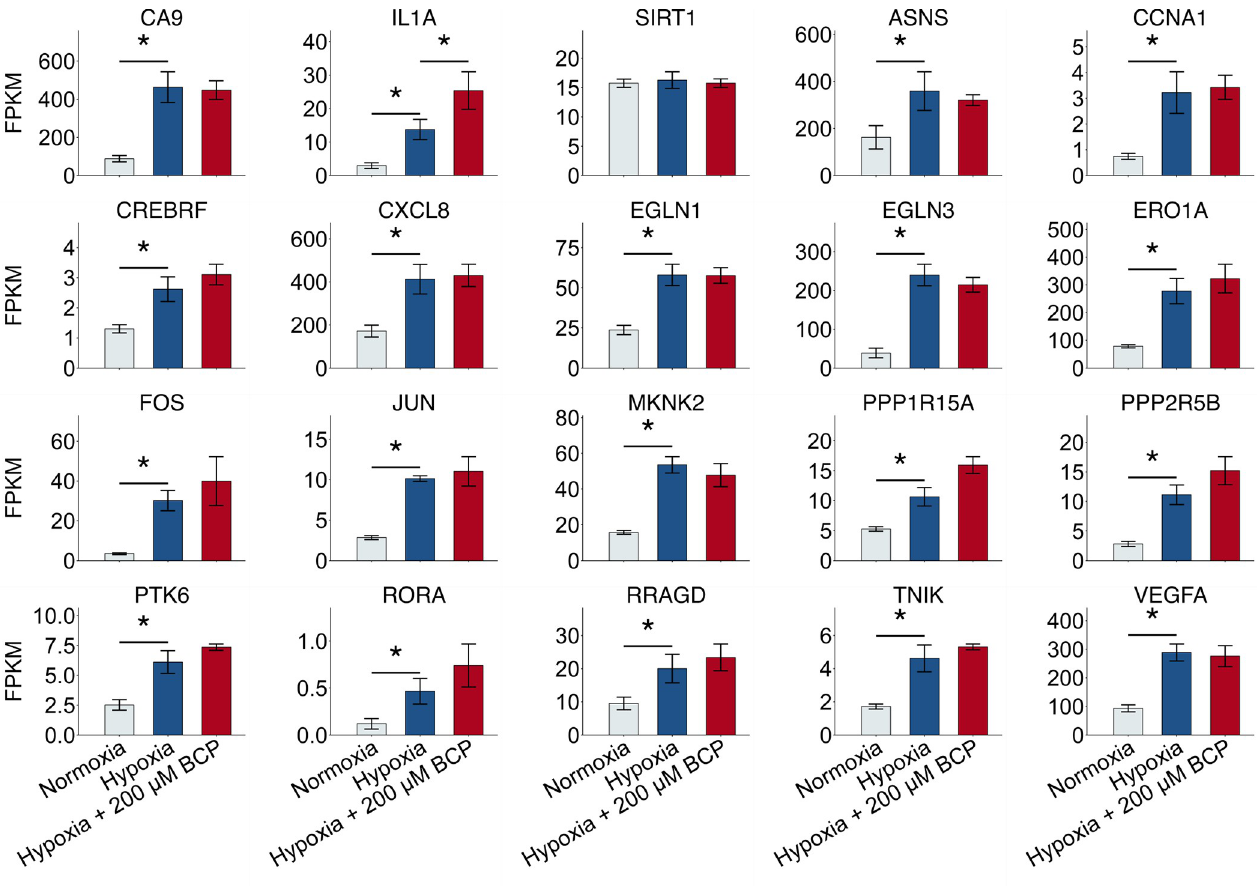
Fig 7. Hypoxia-sensitive stress genes are largely unaffected by BCP. RNAseq data (GSE125511) generated from cells exposed to hypoxic conditions in the presence or absence of BCP were queried for hypoxic-sensitive glycolytic genes. Bars represent 3 independent experiments for each experimental condition with a q-value cutoff of � 0.05. Asterisks connecting Normoxia and Hypoxia treatments indicate significant (q-value � 0.05) effects of Hypoxia; asterisks connecting Hypoxia and BCP treatment indicate significant effects of BCP (Interleukin1, alpha subunit [IL1A]